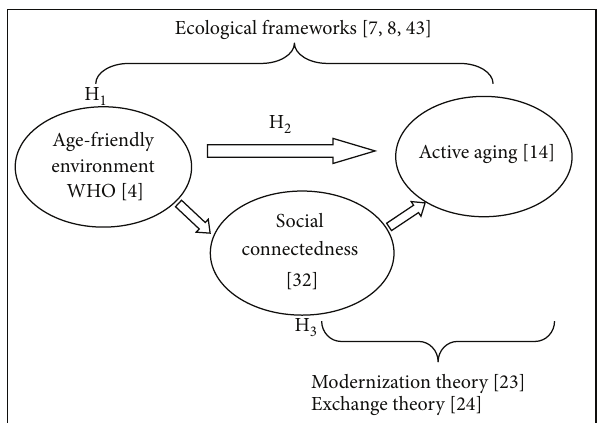
Figure 1: The integrated model of age-friendly environments, active aging, and social